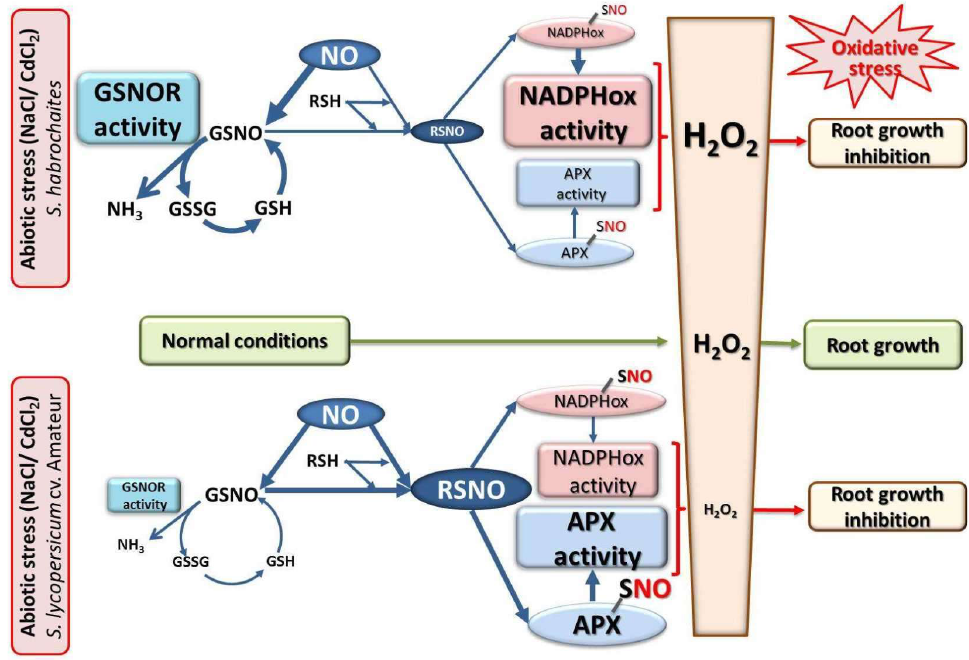
Figure 9. Regulation of Solanum spp. root defence responses to abiotic stress conditions by S-nitrosation. S-nitrosation serves as a regulatory mechanism a ff ecting activities of enzymes involved in the metabolism of ROS, namely, H 2 O 2 , in tomato responses to long-term exposure to salinity or cadmium stress. Stress-induced increase in GSNOR activity and subsequent decrease of S-nitrosothiol levels in S. habrochaites results in reduced S-nitrosation status of APX and NADPH oxidase, associated with decreased APX and increased NADPHox activities, elevated H 2 O 2 levels and oxidative stress conditions in the root cells. In contrast, stress-triggered down-regulation of GSNOR activity in S. lycopersicum cv. Amateur leads to increased S-nitrosothiol levels and increased S-nitrosation protein status, which has an inhibitory e ff ect on NADPHox activity and vice versa , increased APX activity, resulting in lower ROS levels in roots cells. In both genotypes, disturbed ROS homeostasis under stress conditions may contribute to observed inhibition of the root growth and